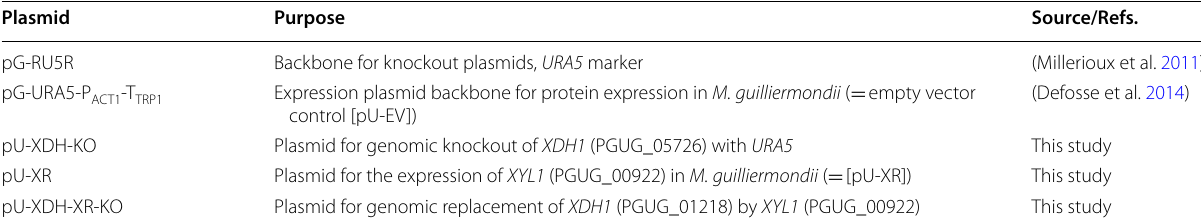
Table 2 plasmids used and generated in this study Plasmid